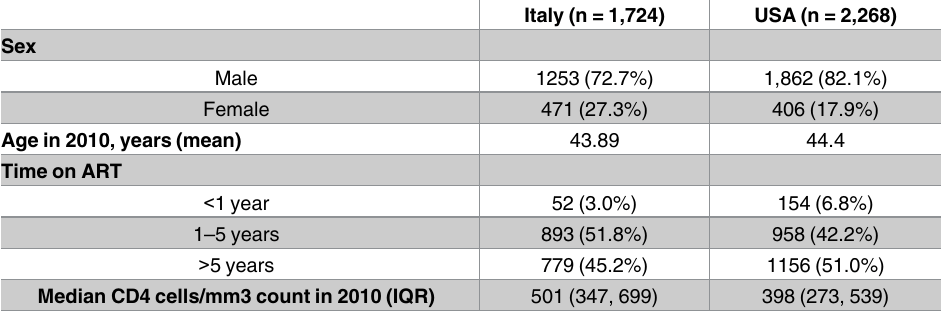
Table 1. Demographic characteristics of the ICONA cohort and cohort of commercially-insured US HIV-positive patients in 2010 used for model parameterization. Abbreviations: Antiretroviral therapy (ART); interquartile range (IQR); United States of America